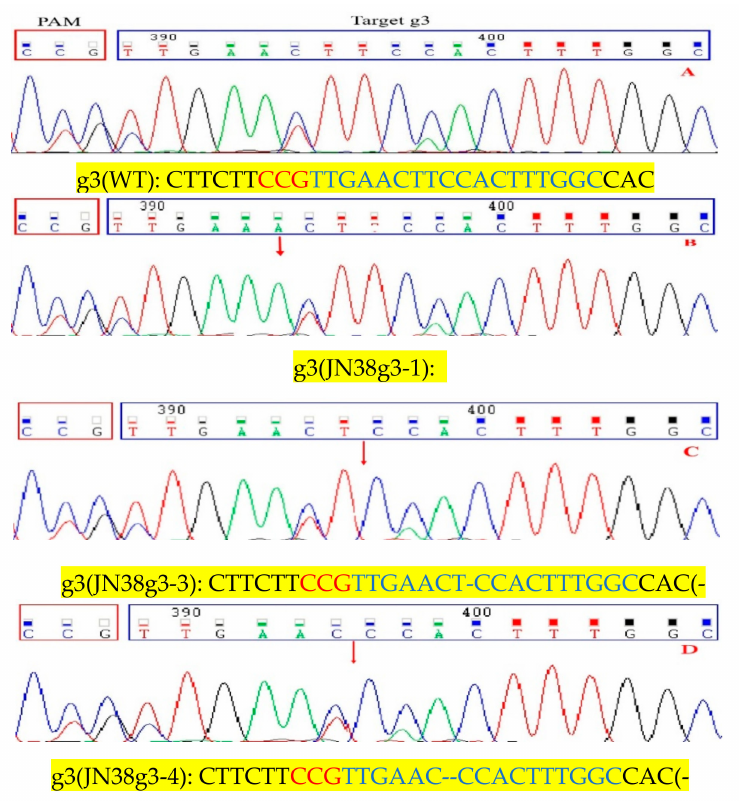
Figure 1. Analyses of sequencing chromatogram data of the target mutant sites of g3. ( A ) Sequences of wild type and representative mutation types induced at target site g3 are presented, respectively. Underline, insertions. Dashes, deletions. ( B – D ) are sequence peaks of wild type and representative mutation types at target site g3, respectively. The red arrowheads indicate the location of mutations.